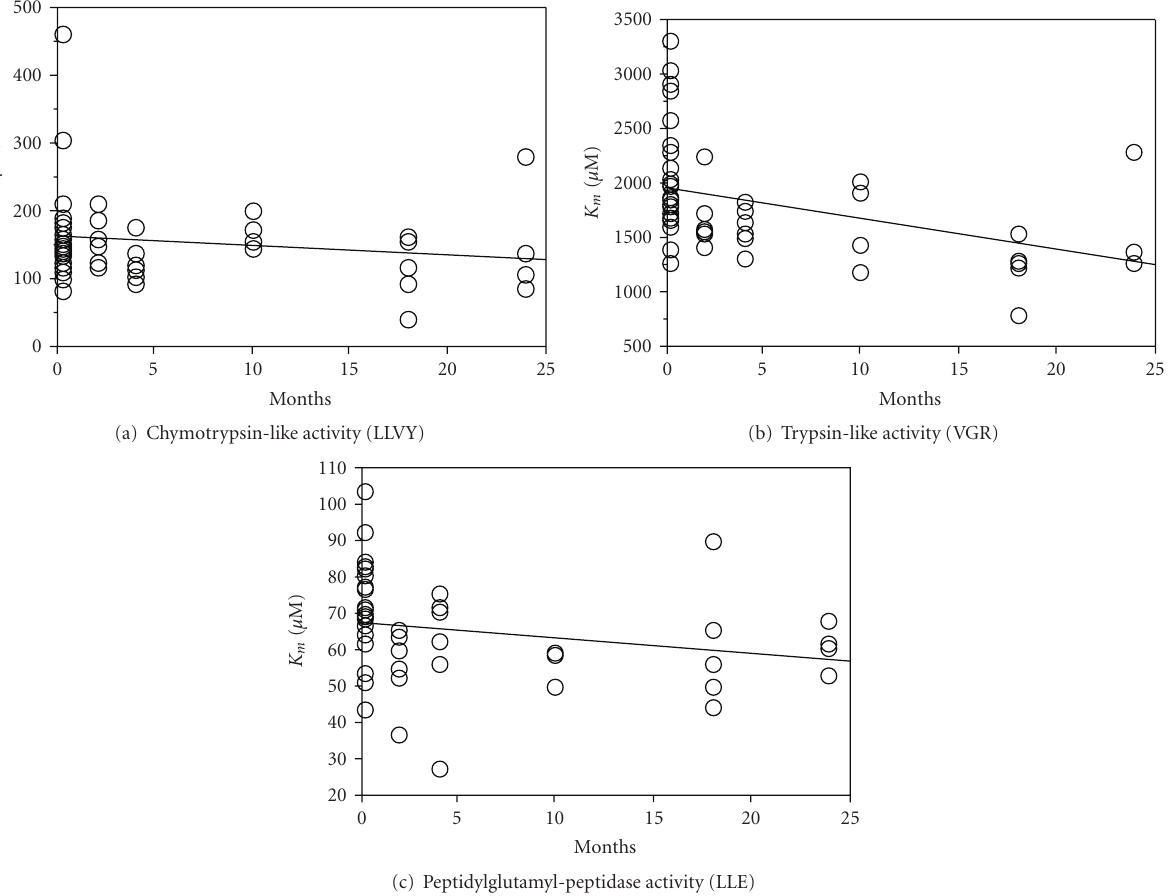
Figure 2: Michaelis-Menten constants ( K m ) of the proteasome in rat brain with age. Michaelis-Menten constants of the proteasome in rat brain plotted against age: K m -values were obtained as described in Figure 1. (a) Chymotrypsin-like activity: R 2 = 0 . 024, P = . 291 . (b) Trypsin-like activity: R 2 = 0 . 189, P = . 002 . (c) Peptidylglutamyl peptidase activity: R 2 = 0 . 060, P = . 094 . A P -value of less than .05 was considered statistically